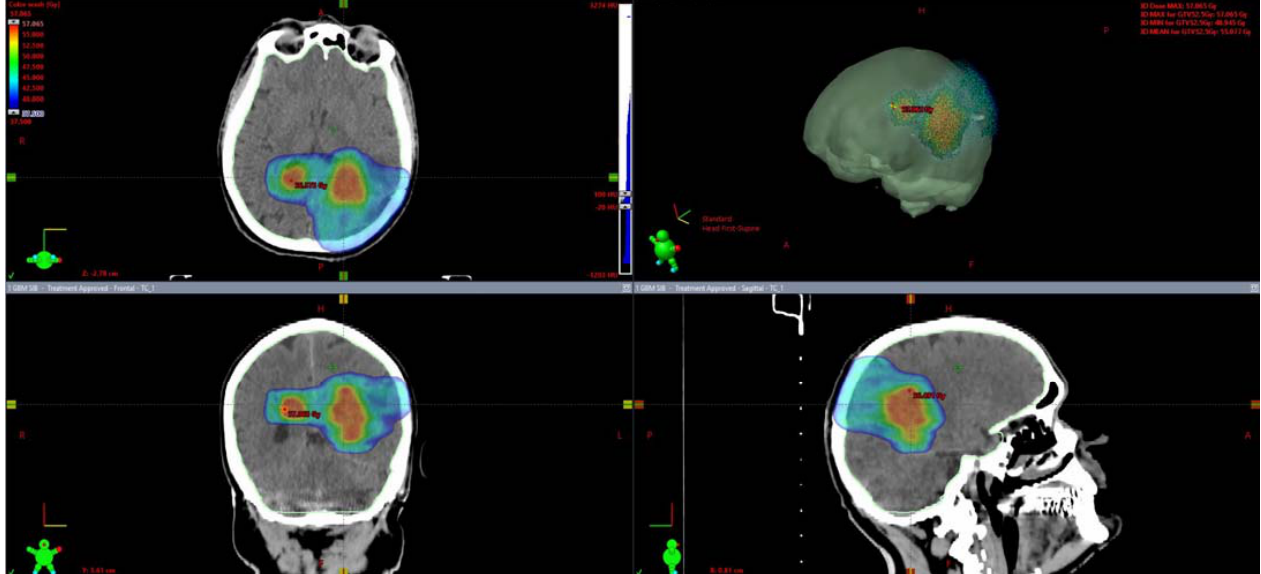
Figure 1. Example of a volumetric arc therapy treatment plan with simultaneous integrated boost. For RT planning, 6 × flattening filter free (FFF) and volumetric modulated arc therapy (VMAT) plans were generated with two or more coplanar or non-coplanar partial arcs by TrueBeam TM (Varian Medical System). All treatment plans were optimized for PTV so that more than 98% of the PTV received at least 95% of the prescribed dose. The